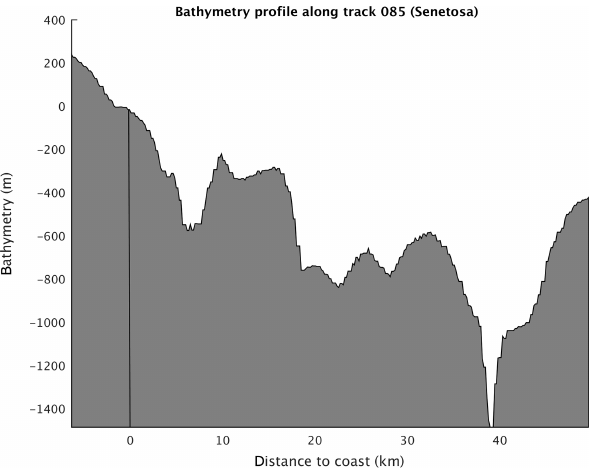
Figure 13. Bathymetric profile (meters) along Jason track 85 from 45km offshore to the coast.